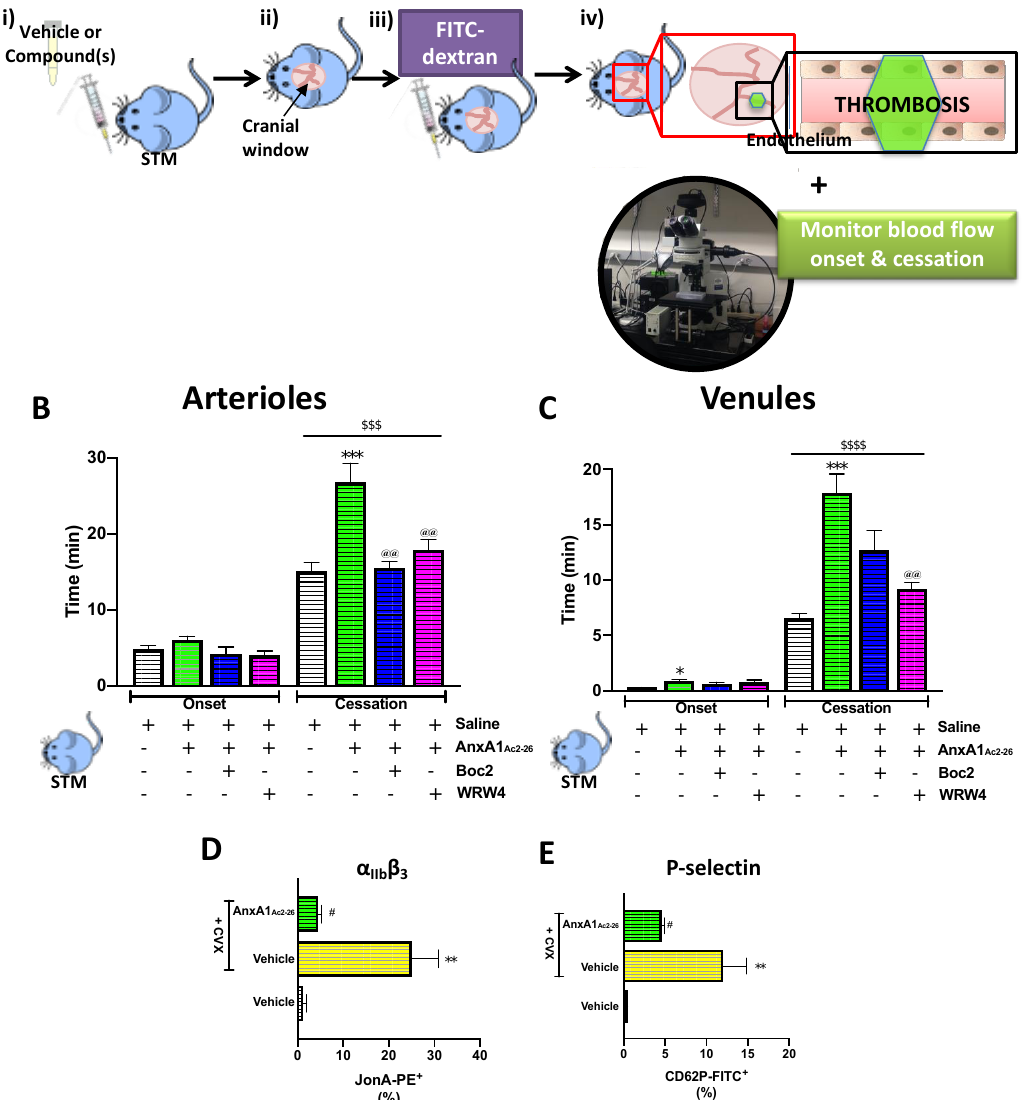
Figure 3. AnxA1 Ac2-26 a ff ords protection against cerebral thrombo-inflammation in STM and modifies cell surface expression of platelet receptors. ( A ) Schematic showing the experimental protocol: (i) sickle cell transgenic mice (STM) were treated with vehicle (saline) or compound(s): AnxA1 Ac2-26 (4 mg / kg) with / without pan FPR antagonist Boc2 (0.4 mg / kg) or FPR2 / ALX antagonist WRW4 (2.2 mg / kg) 20 min (mins) prior to thrombosis. (ii) A cranial window was performed and (iii) FITC-dextran was injected (10 mg / kg of 5%) and allowed to circulate for 10 min before STMs were subjected to (iv) intravital microscopy and light / dye-induced thrombus formation. Onset time and blood flow cessation times were recorded for cerebral ( B ) arterioles and ( C ) venules. ( D + E ) Activated integrin α IIb β 3 and P-selectin were quantified using flow cytometry in platelets isolated from STM following 15 min stimulation with GPVI collagen receptor agonist, convulxin (CVX, 1.7 ng / mL). Vehicle (saline) or AnxA1 Ac2-26 (30 µ M) was given 30 min prior to activation, followed by vehicle (saline) or LPS (7.5 µ g / mL for 5 min). ( D ) % of activated integrin α IIb β 3 (JON-A) and ( E ) % of activated P-selectin expression (CD62P). Data are means ± SEM of 5–6 mice / group. * p < 0.05, ** p < 0.01, *** p < 0.001 vs. corresponding vehicle (saline). @@ p < 0.01 vs. corresponding Ac2-26 group. $$$ p < 0.001, $$$$ p < 0.0001 vs. same group for onset time. # p < 0.05 vs. CVX + vehicle group.